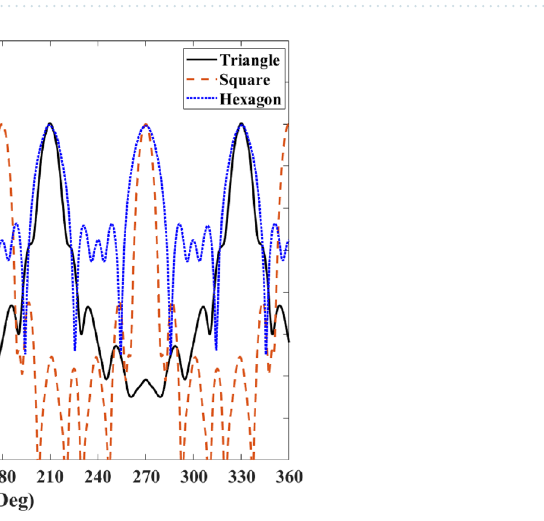
Figure 8. Real part of the electric field for the cylindrical wire excited by an electric current and enclosed by the physical space’s transformation medium. The results are shown for the transformation medium depicted in ( a ) Fig. 3b, ( b ) Fig. 3c, and ( c ) Fig. 3d.